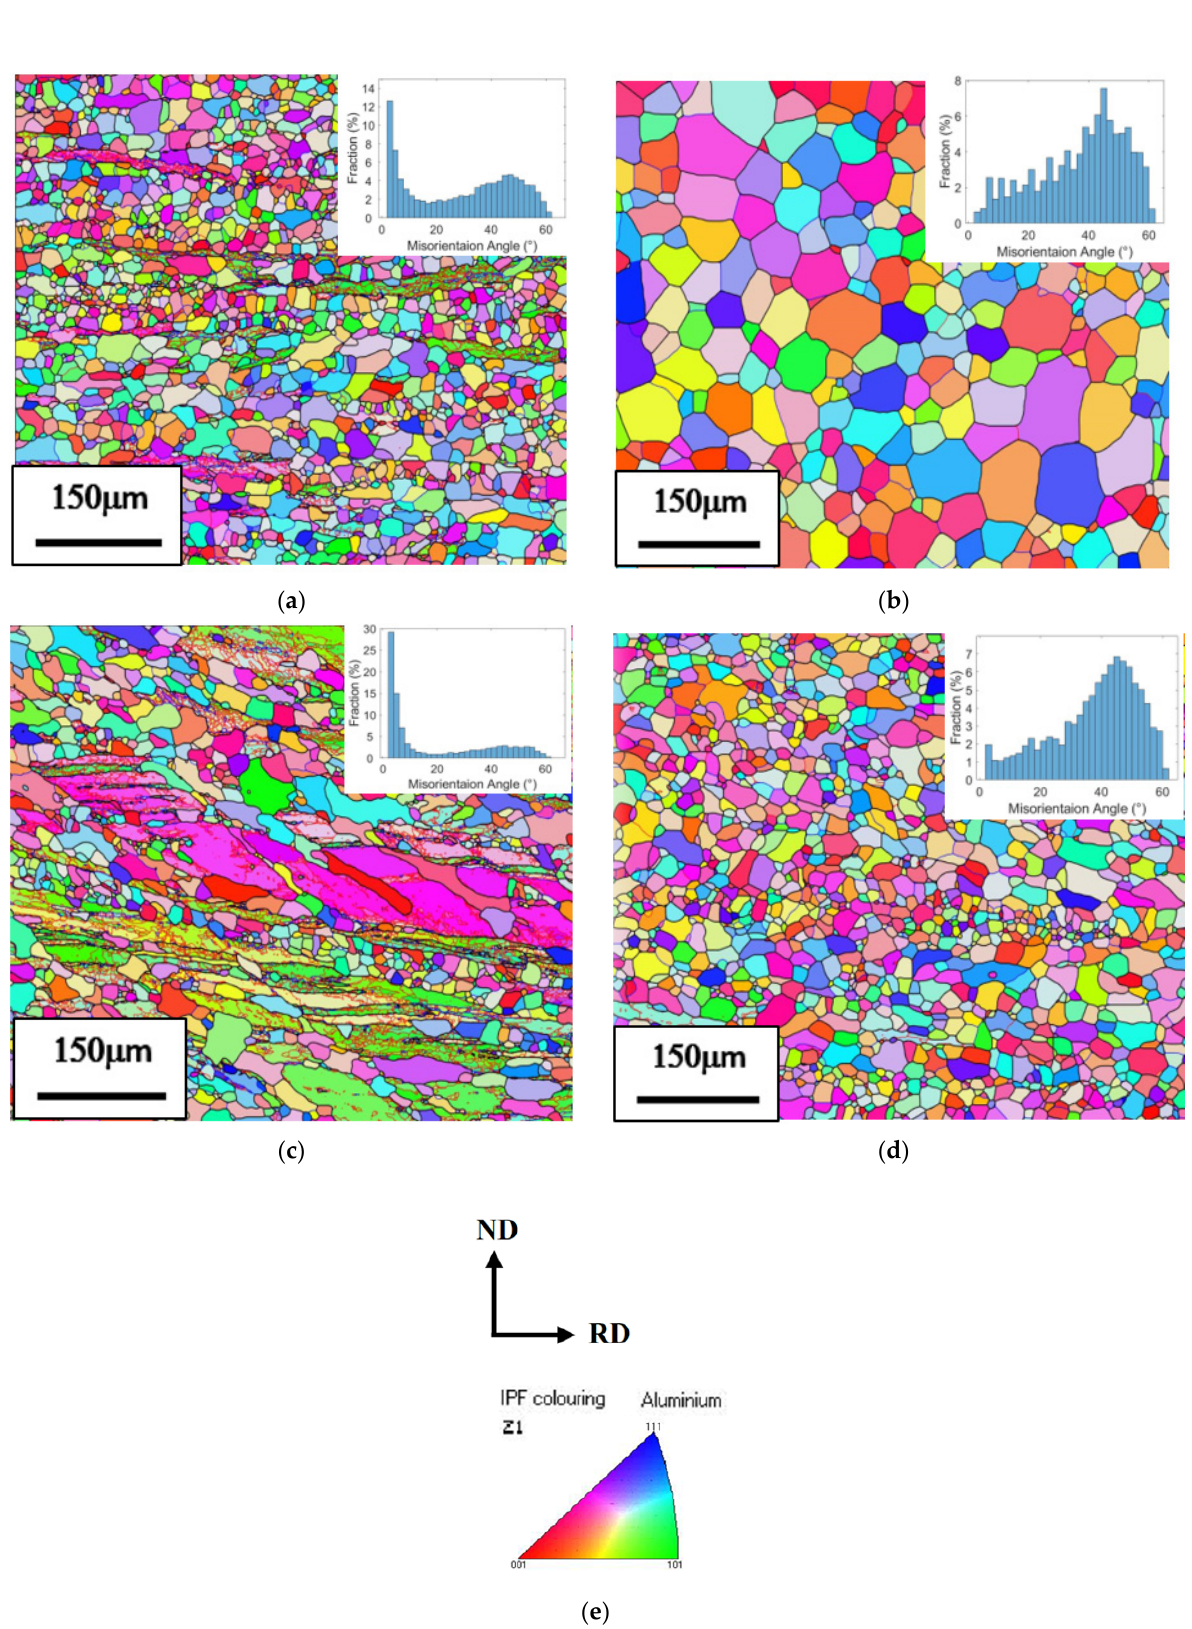
Figure 4. Grain orientation micrographs and the grain boundary angle bar graph under different annealing processes: ( a ) alloy B annealed at 350 °C; ( b ) alloy B annealed at 450 °C; ( c ) alloy C annealed at 350 °C; ( d ) alloy C annealed at 450 °C; ( e ) IPF(Inverse Pole Figure) coloring map and cross-sectional direction. ND, normal direction; RD, rolling direction